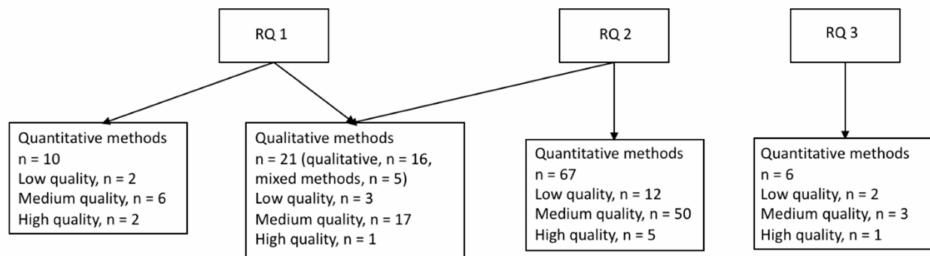
Figure 2. Studies of the healthcare industry sorted by research question and methodology. Research questions (RQs): During an epidemic or pandemic caused by a coronavirus: (1) How is the work environment affected? (2) What are the associations between work environment factors and employee health? (3) What are the effects of interventions to improve the work environment or